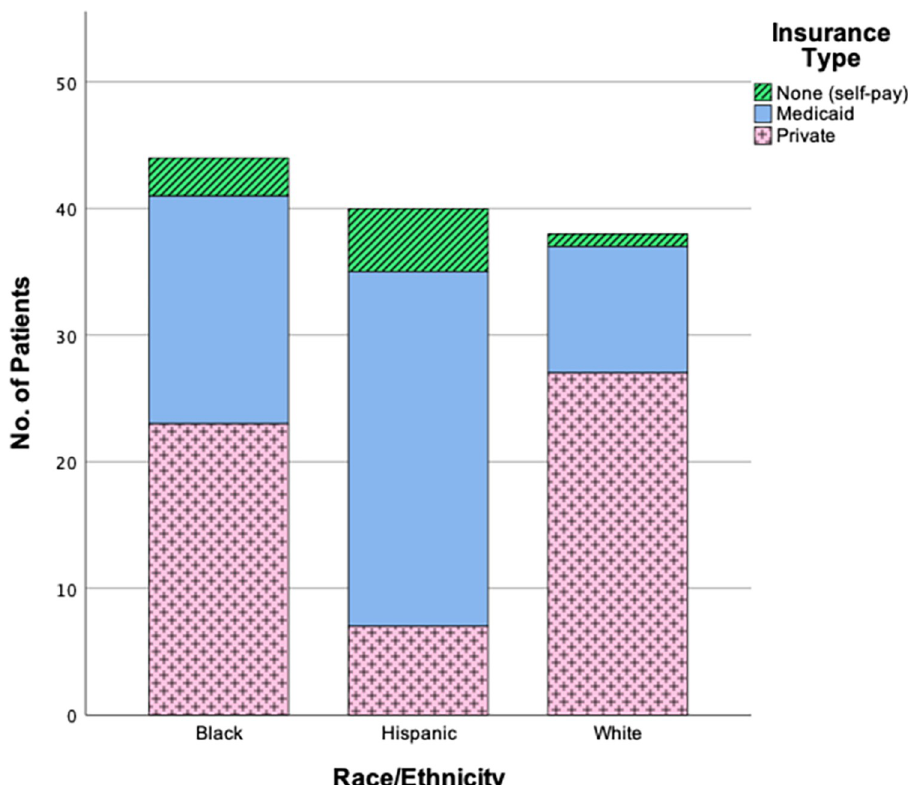
Fig 3. Insurance types separated by race and